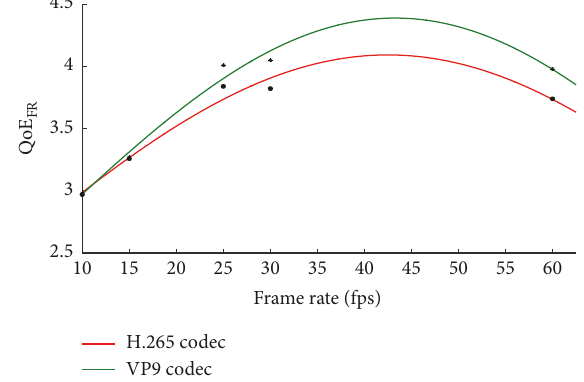
Figure 14: Relationship between frame rate (fps) and QoE subjective